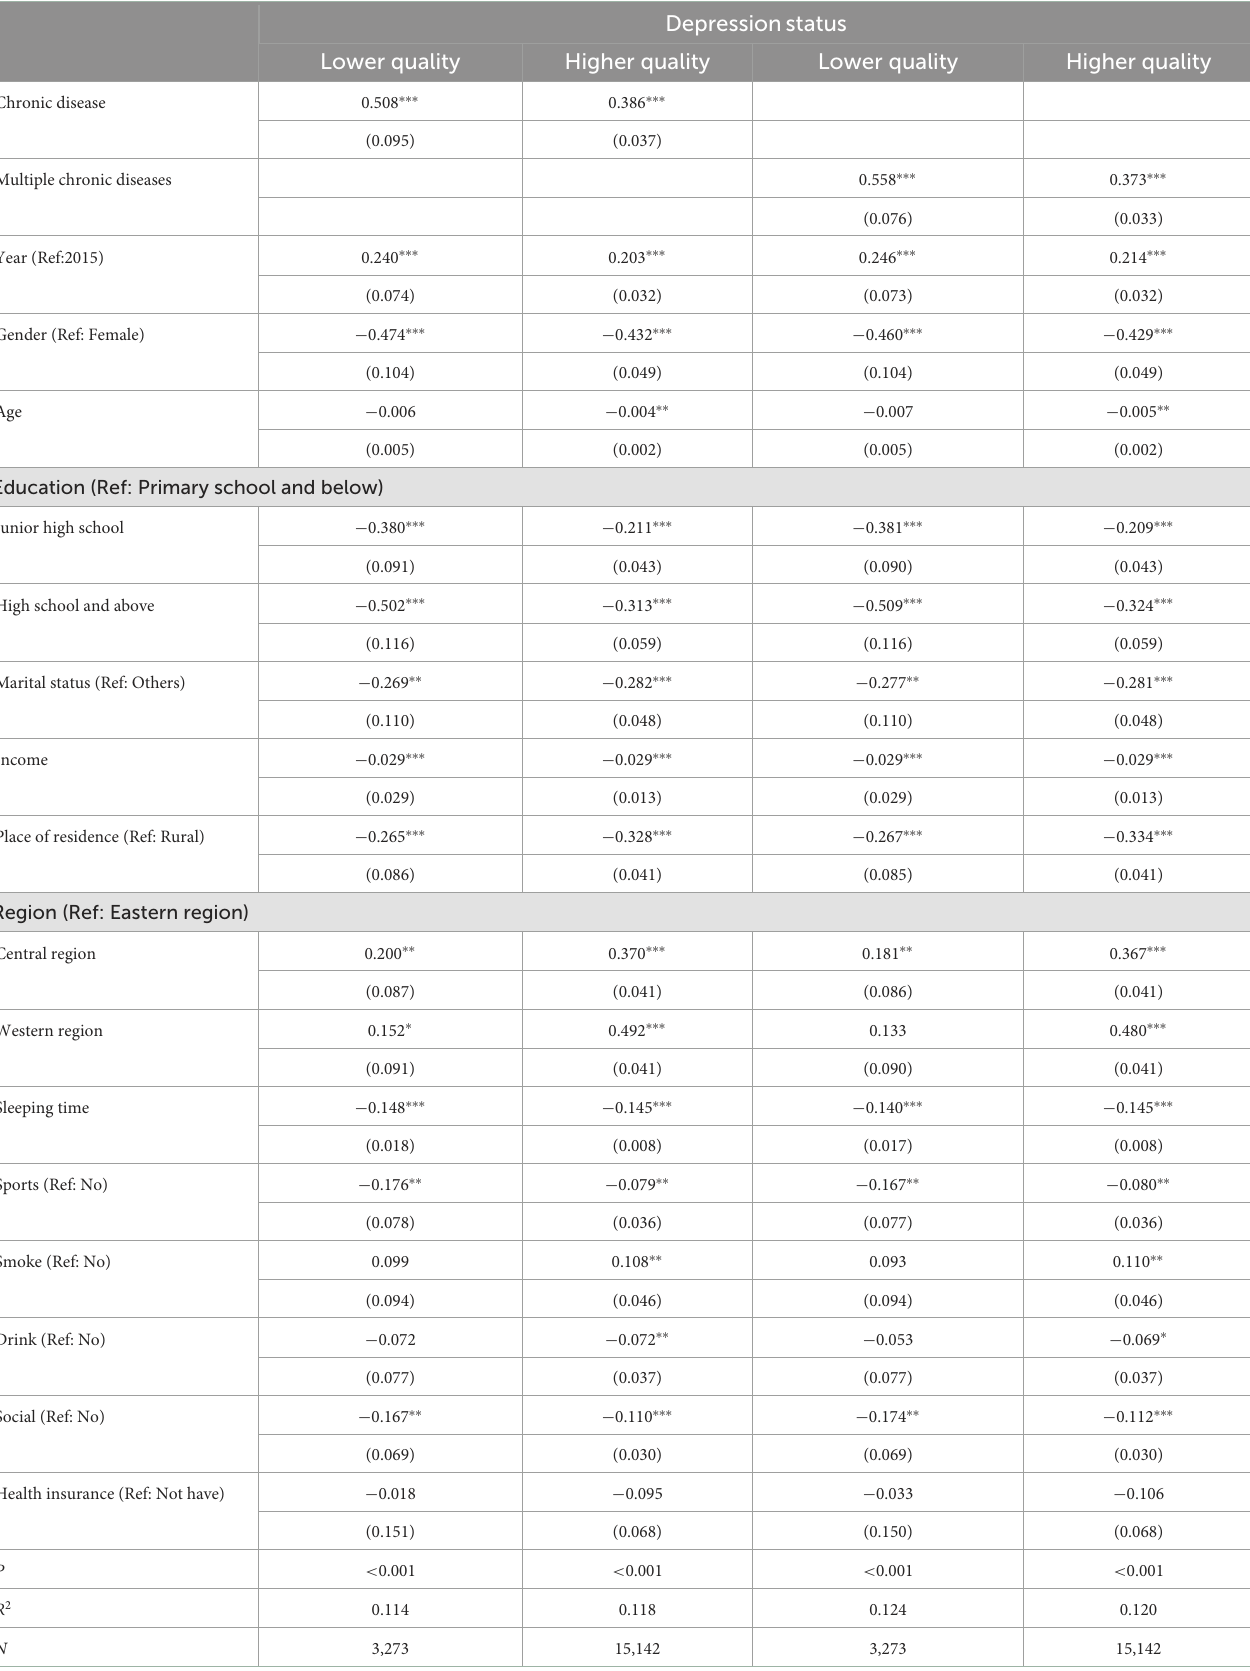
TABLE 7 Adjusted regression results of health service